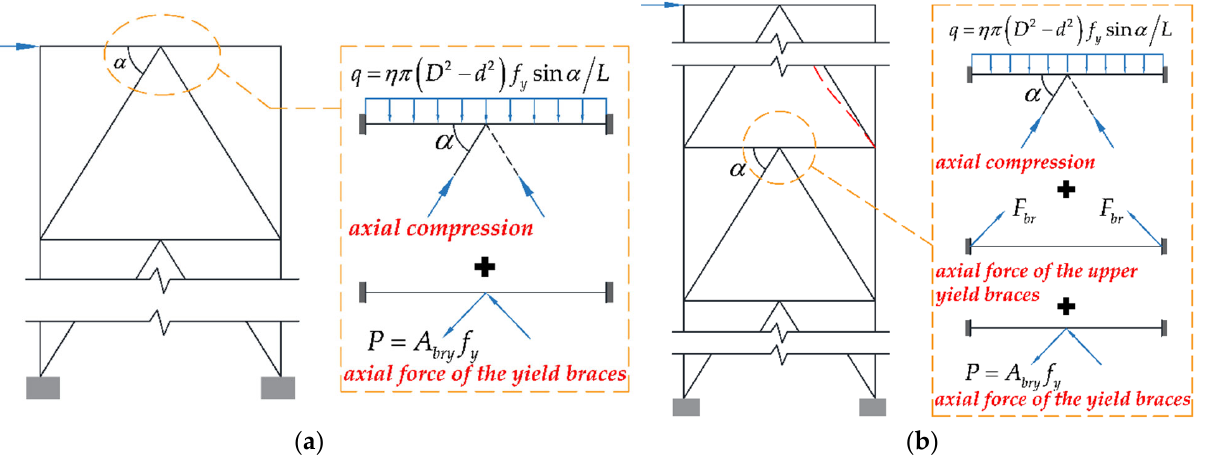
Figure 2. Calculation schemas for the plastic bending yield strength of the beam. ( a ) a top floor beam affected by two braces; ( b ) a typical floor beam affected by four braces. The model of a top floor beam must correctly represent the beam’s bearing capacity, the bending of the horizontal force exerted by the braces, and the bending of the vertical uniform force transferred from the braces’ axial compression, as shown in Equation (1).